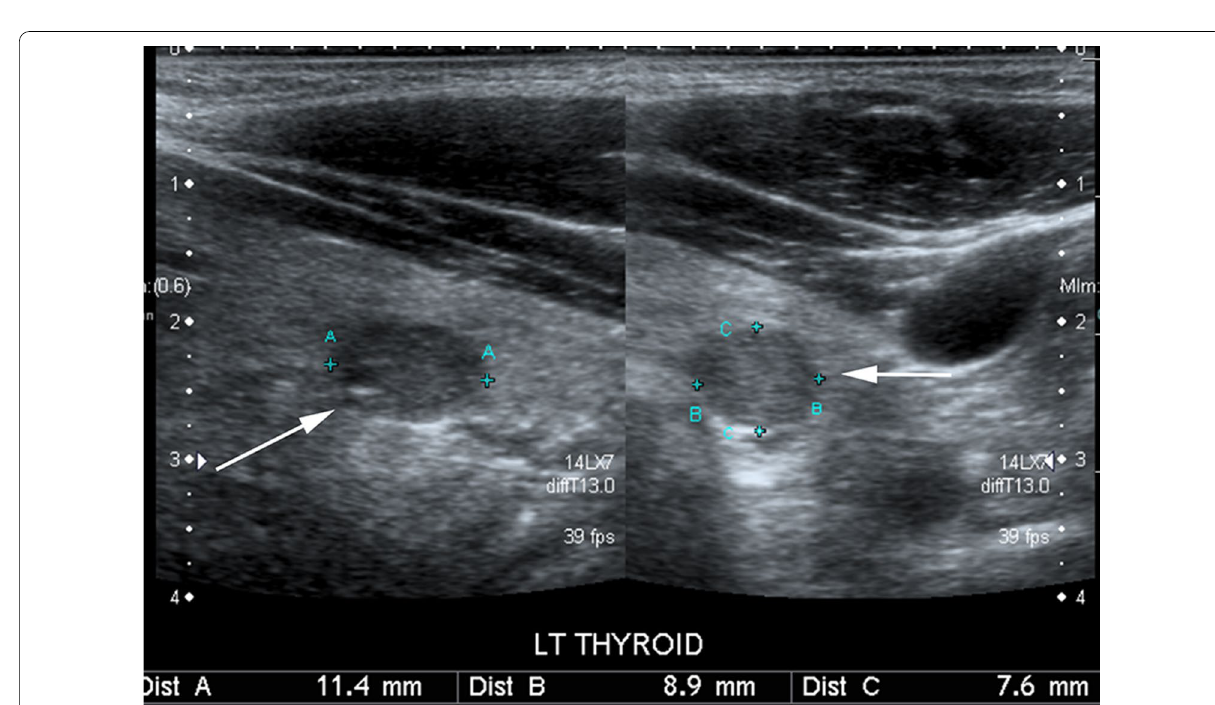
Fig. 2 38-Year-old male with 11 mm PTC in left lobe of thyroid gland (arrow). The image depicts the consistent and reproducible three-axes technique to measure thyroid nodules described in ACR Thyroid Imaging, Reporting and Data System (TI-RADS). Measurements include the maximum dimension on an axial image (distance B on the image), maximum dimension perpendicular to the axial measurement on the same image (distance C) and the maximum longitudinal image on a sagittal image (distance A). Following the above protocol decreases the probability of incorrect measurements at AS follow-up scans performed by different operators in a busy clinical department of a large academic